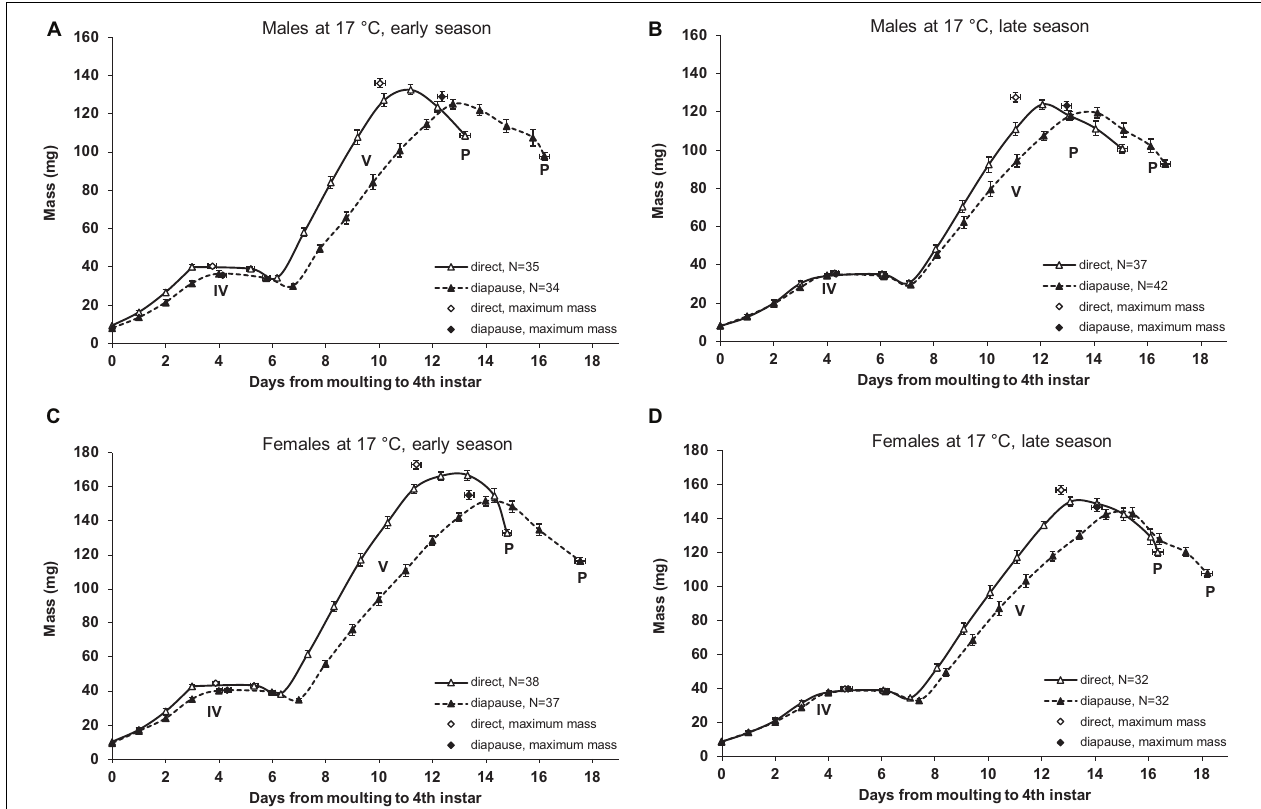
FIGURE 2 | Growth curves of Araschnia levana larvae reared at 17 ◦ C. Direct development [“long day” (18L:6D) photoperiodic treatment] and diapause [“short day” (12L:12D) photoperiodic treatment] pathways were induced in 2011. (A) Male larvae reared in early season. (B) Male larvae reared in late season. (C) Female larvae reared in early season. (D) Female larvae reared in late season. Direct development and diapause pathways were induced. See Figure 1 for